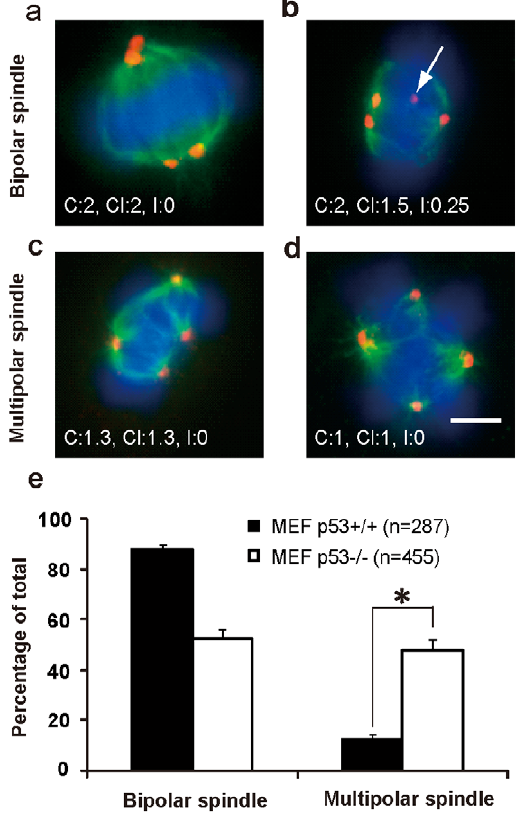
Figure 3. The absence of p53 promotes the formation of multipolar spindles in tetraploid cells. p53 + / + and p53 -/- MEF cells cultured on glass coverslips coated with 0.1% gelatin were treated with 0.5 m g/ml Cyto-B for 12 h. After washing, cells were cultured for additional 8 h in drug-free culture medium and subjected to immunofluorescence detection of mitotic spindles ( a -tubulin staining, green fluorescence) and centrosomes ( c -tubulin staining, red fluores- cence). Nuclei were counterstained with DAPI (emitting in blue). Representative images of each spindle type and C, Cl and I values are shown respectively on down-left. (A) A bipolar spindle with two centrosomes clustered loosely on lower pole or closely on upper pole. (B) A bipolar spindle showing two centrosomes clustered on one pole and one centrosome inactivated (white arrow). (C) A tripolar spindle with two centrosomes loosely clustered on one pole. (D) A tetrapolar spindle with one centrosome on every pole. Bar=10 m m (A-D). (E) Analysis of spindle polarity at metaphase of cells with extra centrosomes (* P , 0.001, 2 6 2 x 2 test). Error bars are standard deviation, from results of 3 independent experiments. n, the number of cells analyzed.